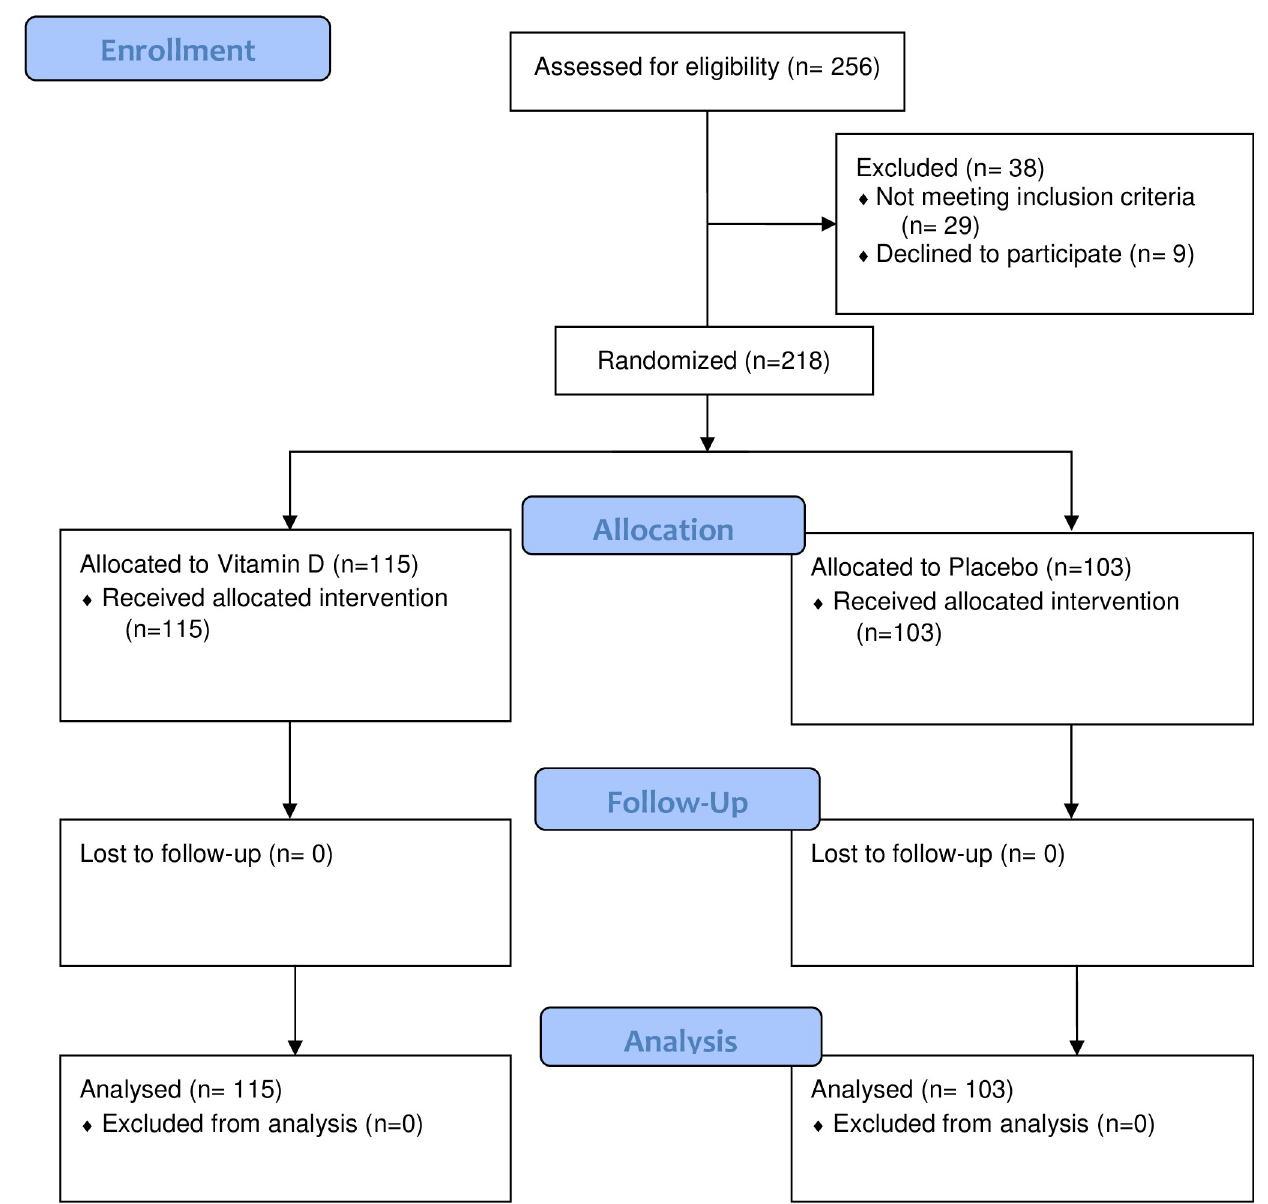
Fig 1. Flow of the patients in the CARED